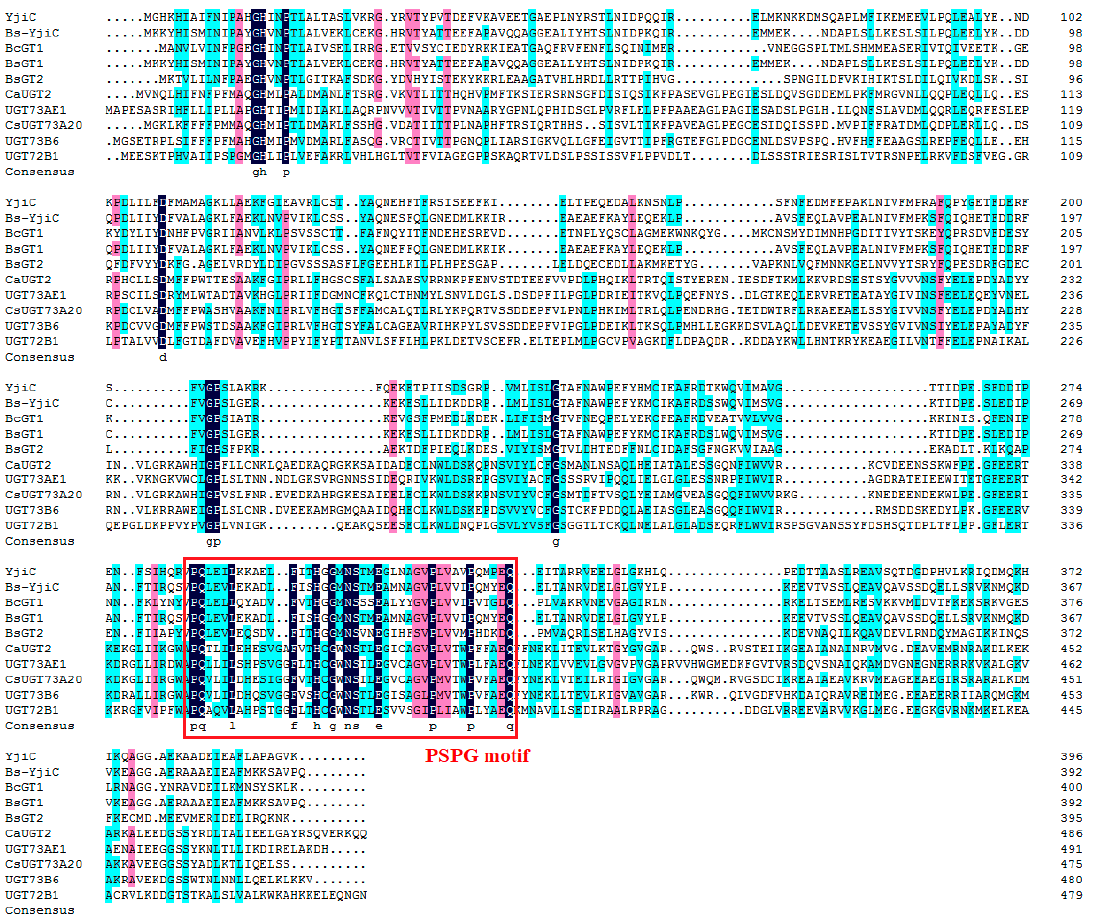
Figure 6. Sequence alignment based on the full-length proteins of BsGT1 , BsGT2 , and eight GTs from plants and bacteria, and the five GTs from plants are involved in the glycosylation of secondary metabolites. The PSPG box is marked by the red rounded rectangle.